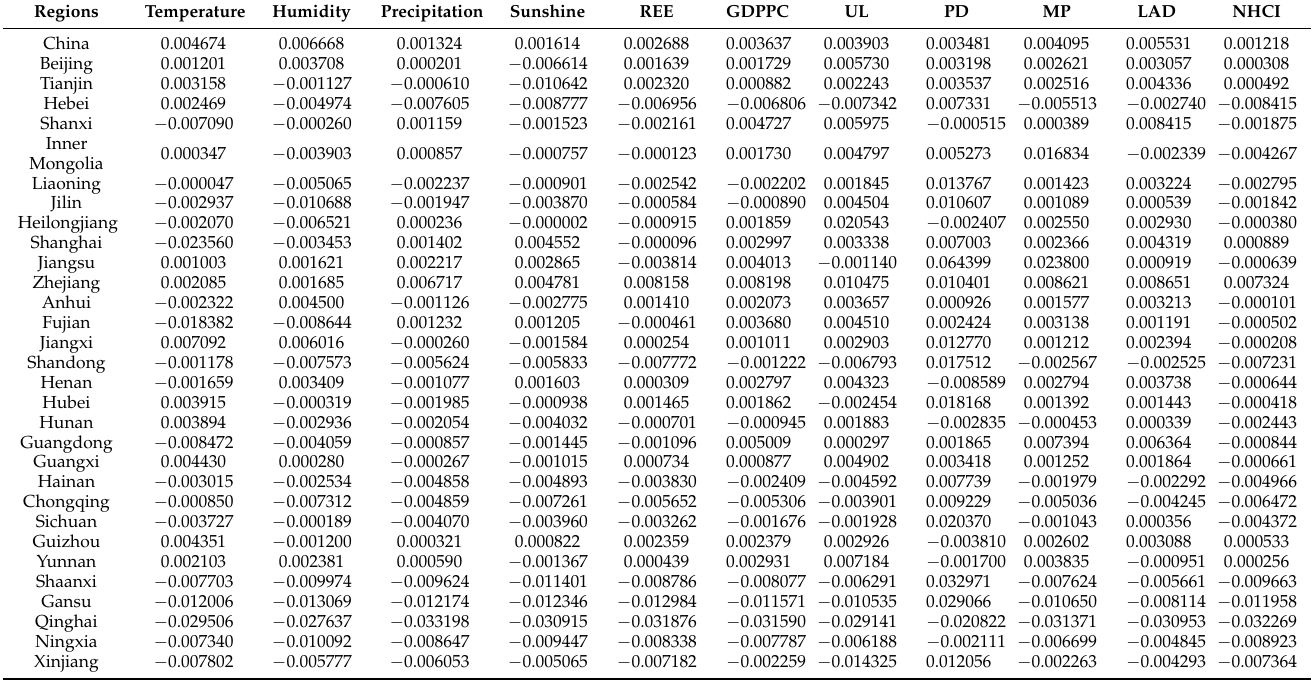
Table 6. How OWT change when each of variables increases by 1% X × (1 + 0.01).